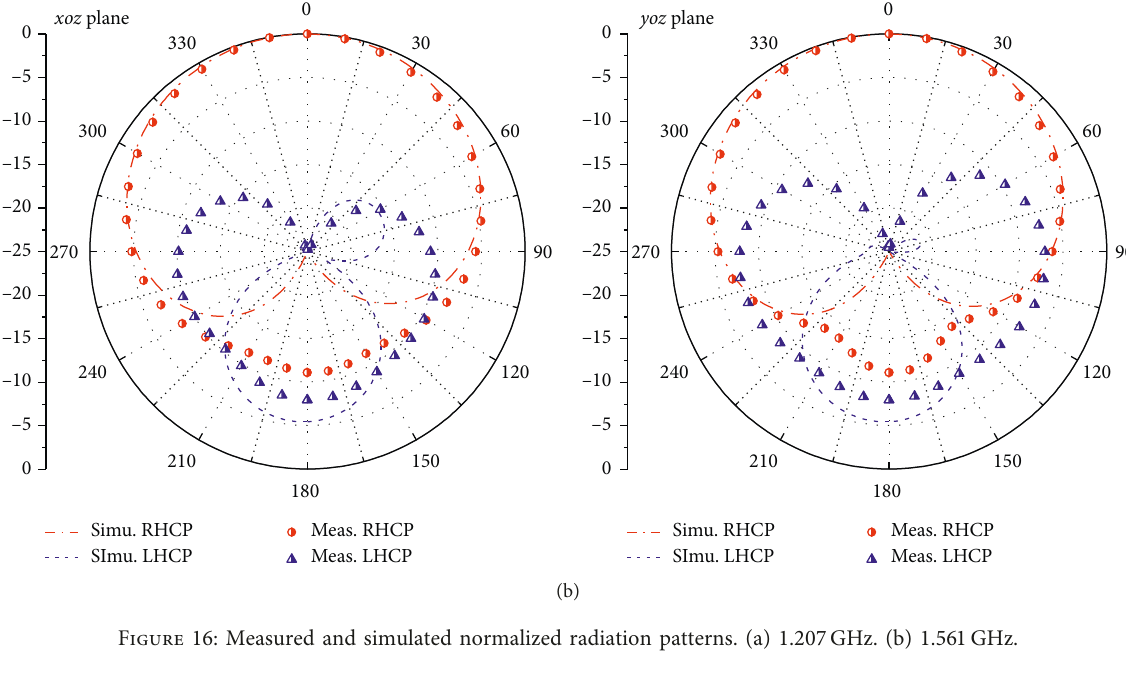
Figure 16: Measured and simulated normalized radiation patterns. (a) 1.207GHz. (b) 1.561 GHz.